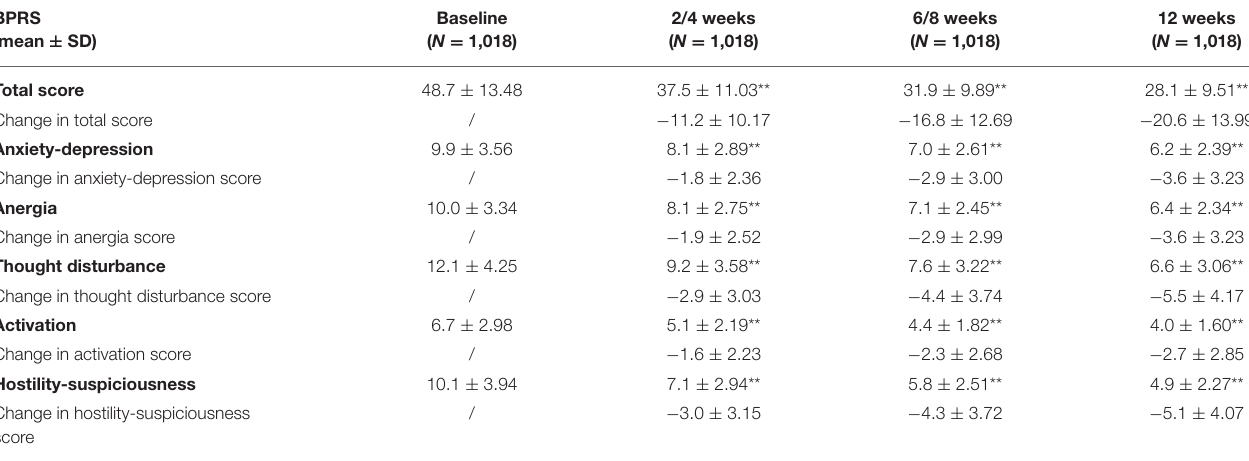
TABLE 3 | Mean changes of BPRS scores using LOCF method from baseline to 12 weeks after initiation of